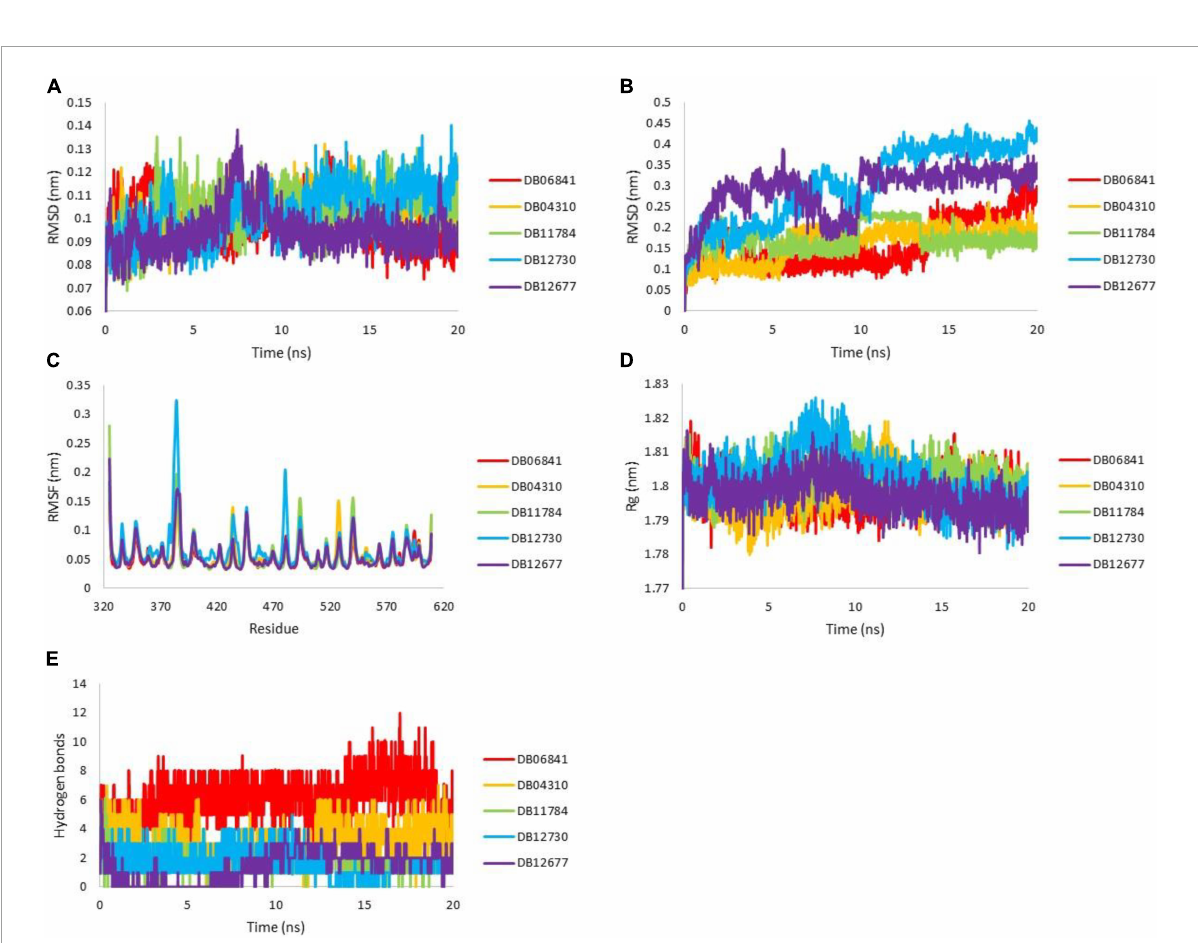
FIGURE6 MD simulation analysis for generated trajectories for Keap1 holo forms: (A) RMSD for Keap1 backbone atoms, (B) RMSD for ligand atoms, (C) RMSF for backbone atoms of Keap1 residues, the (D) radius of gyration for keap1 atoms and (E) hydrogen bonds between the drugs with Keap1. Adopted from